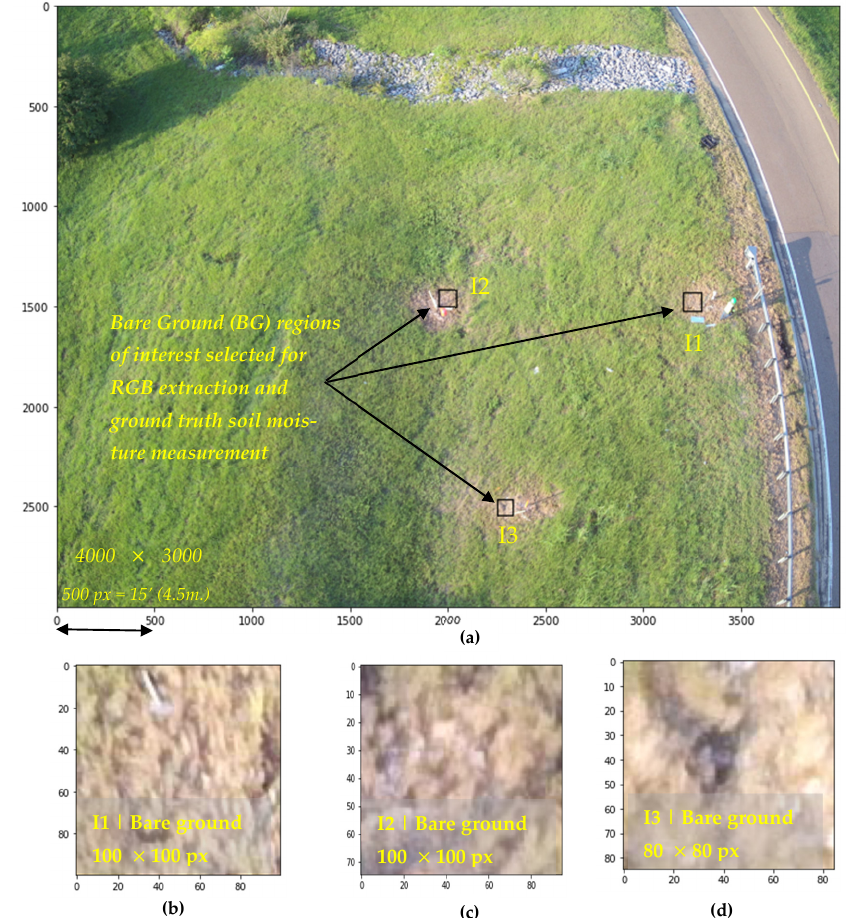
Figure 3. ( a ) Metro Center Highway slope UAV optical image. ( b ) Region of interest 1. ( c ) Region of interest 2. ( d ) Region of interest 3.